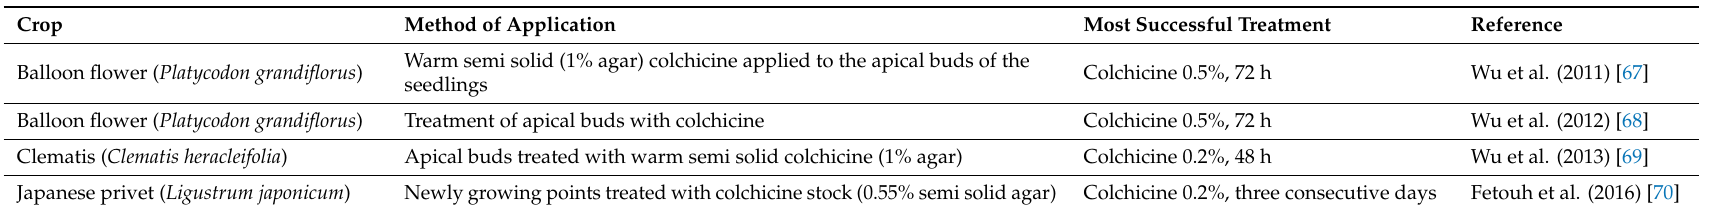
Table 3. Induction of polyploidy in ornamental plants by applying colchicine with semi solid agar method since last fifteen years.